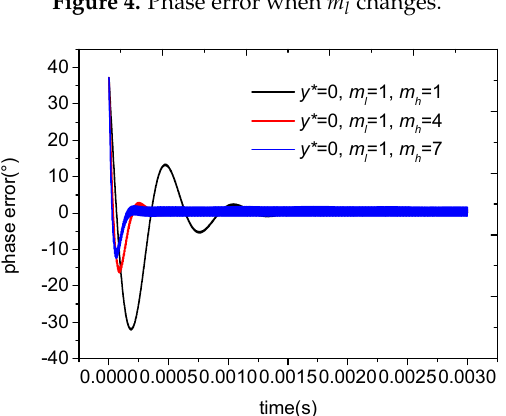
Figure 4. Phase error when m l changes.